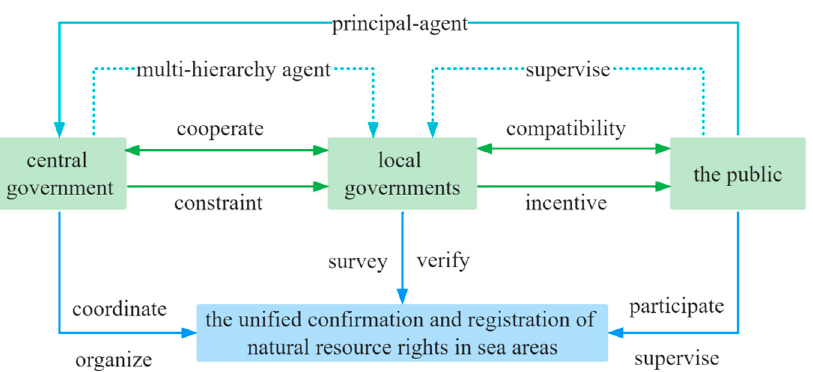
Figure 1. Stakeholder relationship and its interaction mechanism on the UCRNRSA.